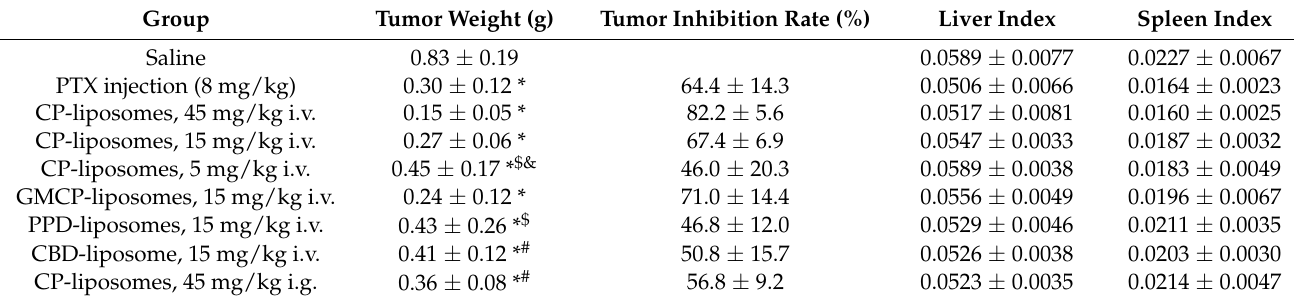
Table 2. In vivo antitumor efficacy and safety